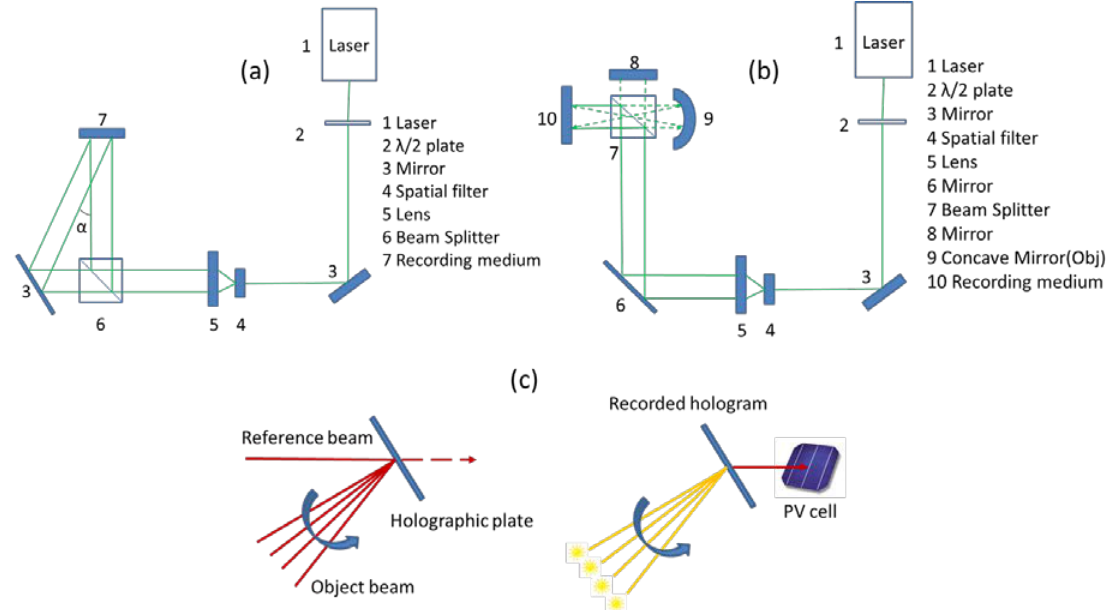
Figure 1. ( a ) Set-up for volume holographic grating recording; ( b ) Set-up for volume phase holographic lenses recording; ( c ) Schematic representation of the recording of multiplexed holographic lenses: the reference beam is fixed while the object beam incident angle is changed during the